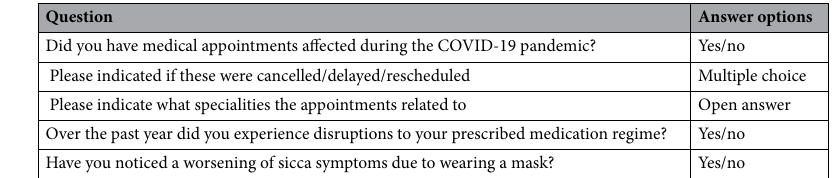
Table 5. Outlining additional questions posed to participants to measure the personal impact of COVID-19 pandemic on participant’s daily